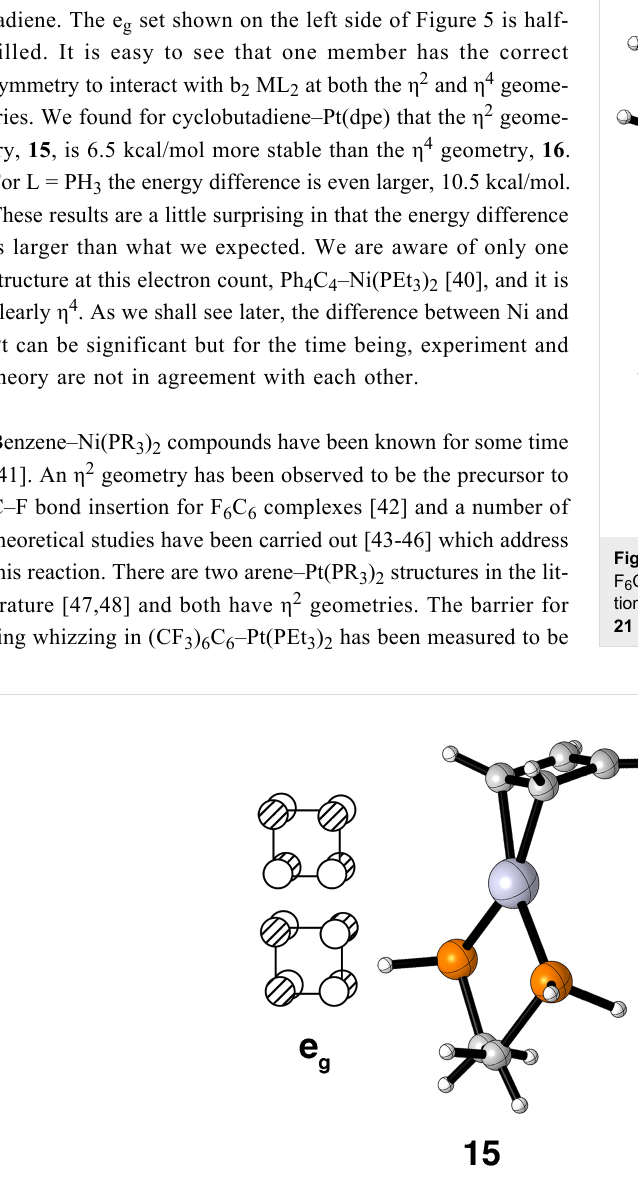
Figure 5: The half-filled degenerate π orbitals in cyclobutadiene. The computed ground state ( 15 ) and transition state ( 16 ) for cyclobutadiene–Pt(dpe) on the right.